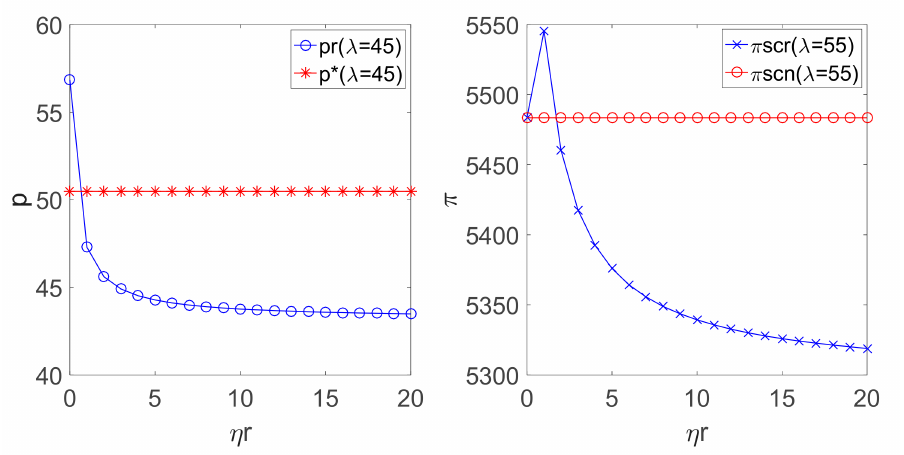
Figure 8. Relationship among p , π sc and η r